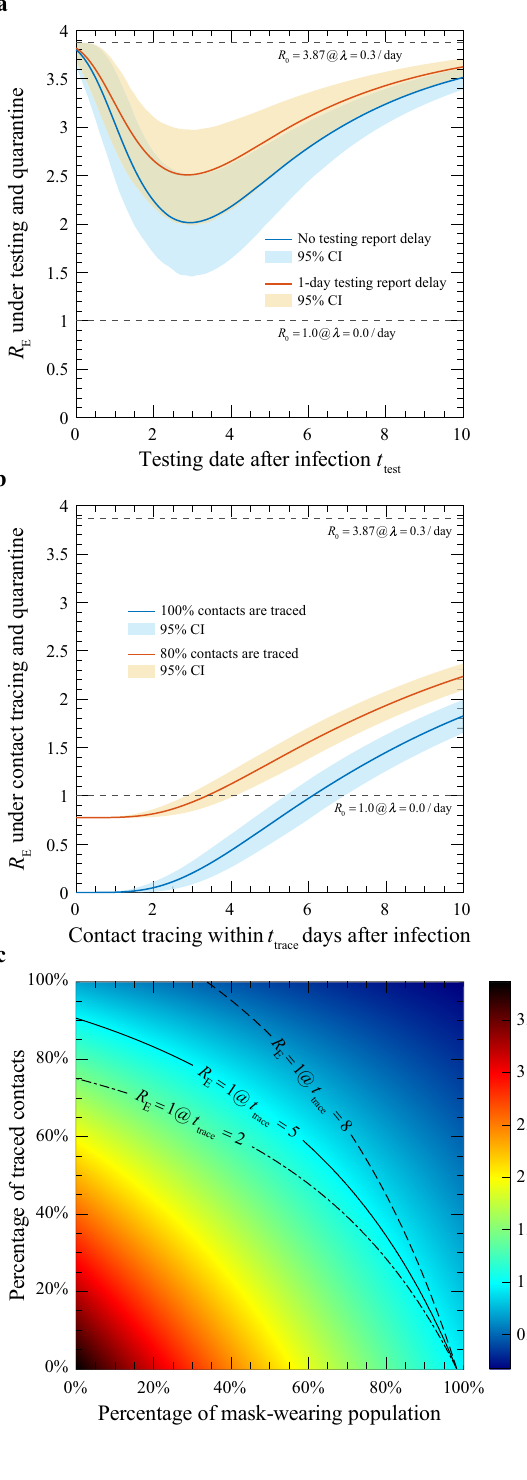
Fig. 4 Reduction of the mean reproduction number upon intervention. a Testing. Results are given for testing with 0 or 1 day reporting delay (blue and red curves), respectively. CI con fi dence interval. b Contact tracing and isolation. Results are shown for 100% (blue) and 80% (red) success rates, respectively. The 95% CIs of the estimated quantities in a and b (shaded areas) were obtained through bootstrap resampling with 1000 replications symptom onset times of 347 cases 11,20,21 and exposure windows of 66 transmission pairs 7 . c Mask-wearing in combination with contact tracing. The heatmap gives the reduced R E when contact tracing is implemented within 5 days after infection, assuming a basal value of 3.87. The solid black line marks the percentages required to reduce R E to 1. The dash-dotted line and the dashed line map out the percentages required to fl atten the epidemic growth when the time frame for contact tracing is reduced to 2 days or relaxed to 8